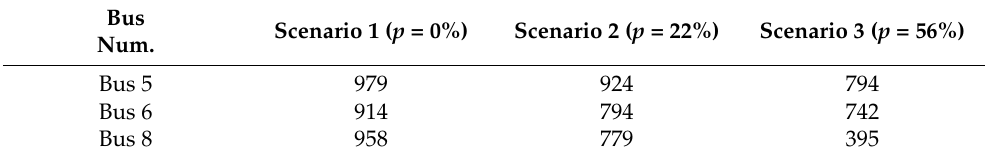
Table 3. Fault level MVA obtained from the capacitor bank switching-based Thevenin impedance. Bus